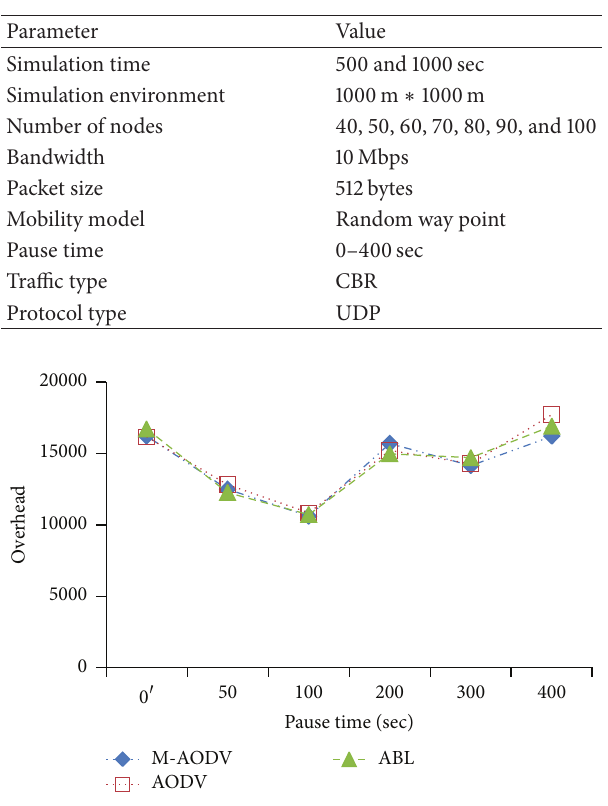
Table 2: Simulation parameters.